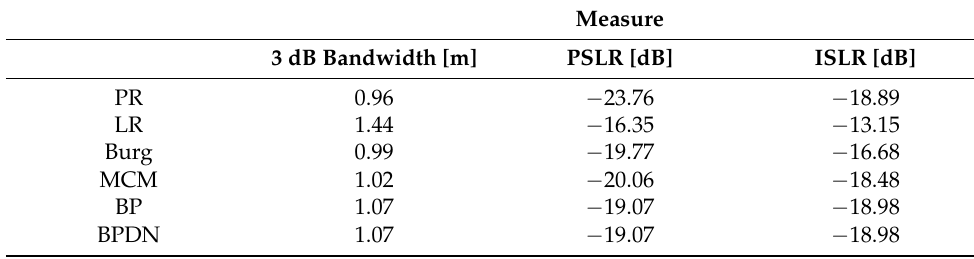
Table 2. Comparison of three quality parameters of azimuth